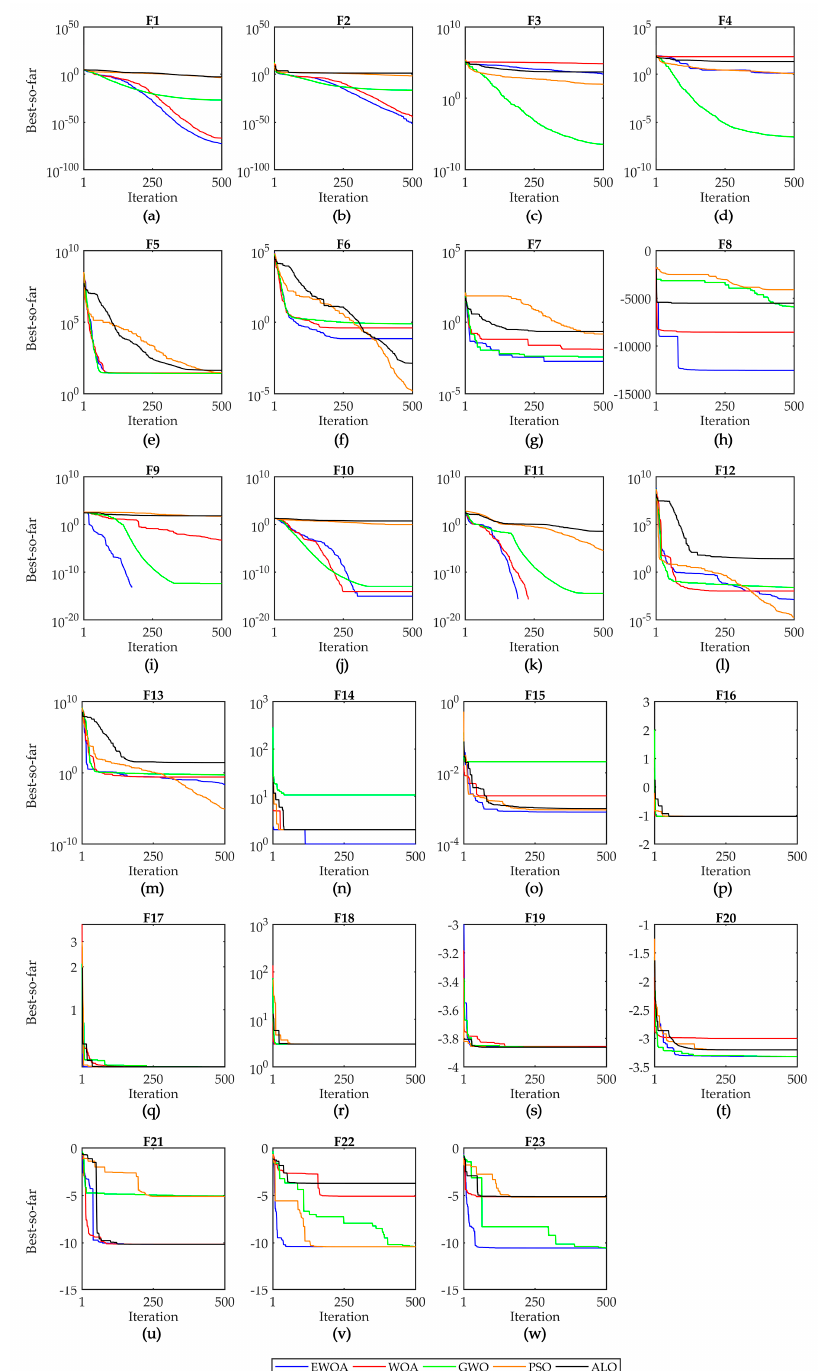
Figure 6. Comparison of convergence curves of enhanced whale optimization algorithm (EWOA) and literature algorithms obtained in some of the benchmark problems. ( a ) Curves of the fitness values for F1; ( b ) Curves of the fitness values for F2; ( c ) Curves of the fitness values for F3; ( d ) Curves of the fitness values for F4; ( e ) Curves of the fitness values for F5; ( f ) Curves of the fitness values for F6; ( g ) Curves of the fitness values for F7; ( h ) Curves of the fitness values for F8; ( i ) Curves of the fitness values for F9; ( j ) Curves of the fitness values for F10; ( k ) Curves of the fitness values for F11; ( l ) Curves of the fitness values for F12; ( m ) Curves of the fitness values for F13; ( n ) Curves of the fitness values for F14; ( o ) Curves of the fitness values for F15; ( p ) Curves of the fitness values for F16; ( q ) Curves of the fitness values for F17; ( r ) Curves of the fitness values for F18; ( s ) Curves of the fitness values for F19; ( t ) Curves of the fitness values for F20; ( u ) Curves of the fitness values for F21; ( v ) Curves of the fitness values for F22; ( w ) Curves of the fitness values for